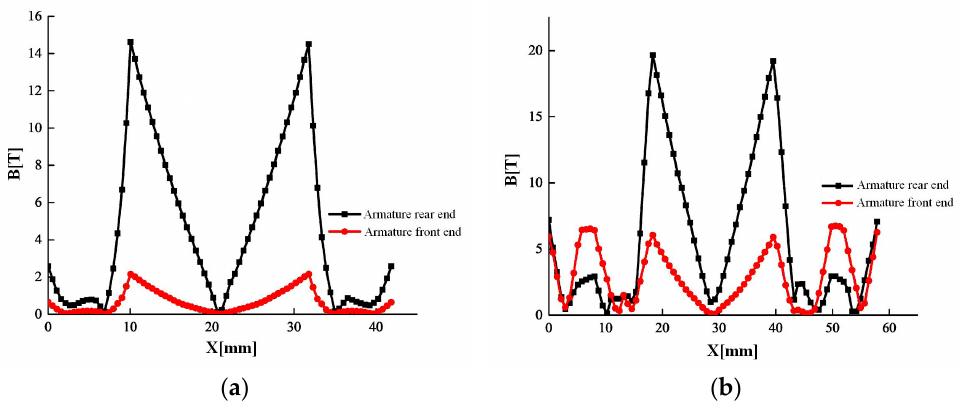
Figure 6. Distribution curve of magnetic induction intensity on the path: ( a ) nonenhanced; ( b ) en- hanced.